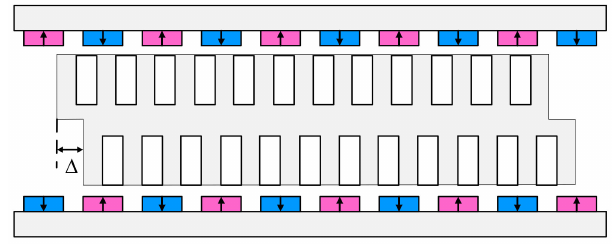
Figure 4. Slot-shift structure of the 120 ◦